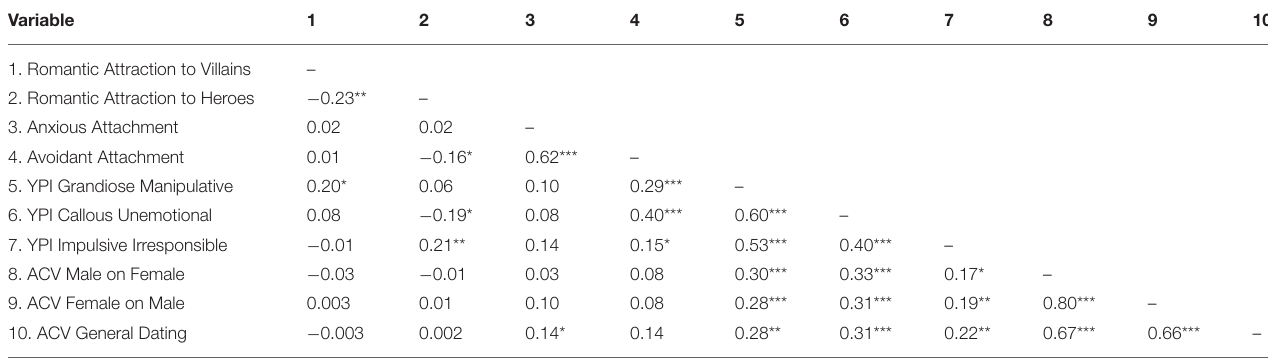
TABLE 7 | Intercorrelations for study variables in Study 2 (Main Study).